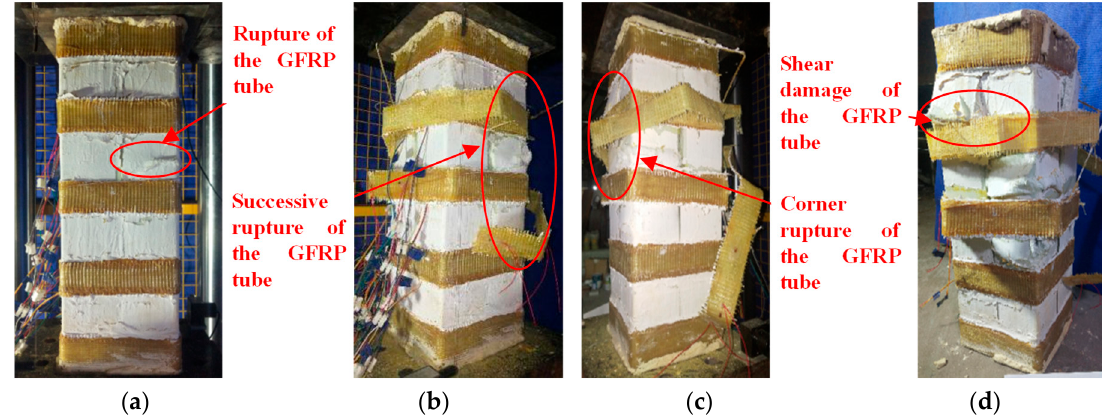
Figure 4. Test phenomenon of specimen W50S85. ( a ) Repture of the GFRP tube; ( b ) Successive rupture of the GFRP tube; ( c ) Shear damage of the GFRP tube; ( d ) Cornr rupture of the GFRP tube.